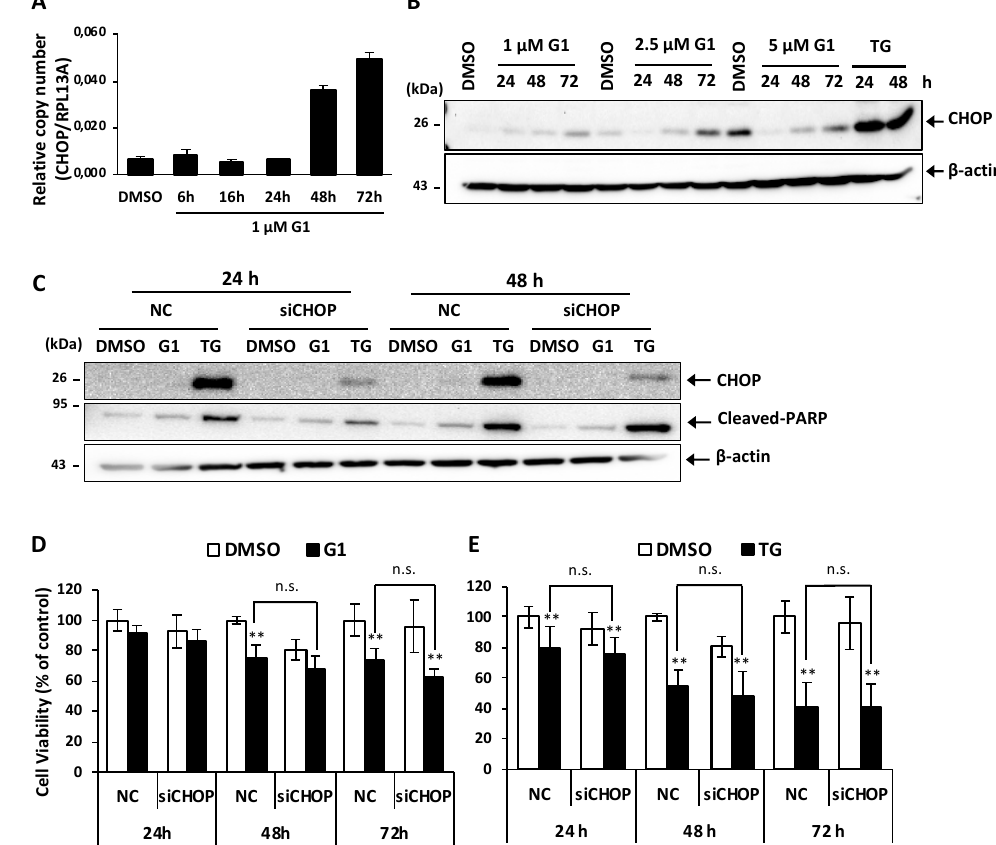
Figure 3. Up-regulation of CHOP expression was not involved in G1-induced cell death in MCF-7 cells. MCF-7 cells were treated with 1, 2.5 and 5 µM G1 at different time points. Total mRNA ( A ) and protein lysates ( B ) were isolated, and the levels of the expression of CHOP-mRNA were measured by real-time PCR and normalized to RPL13A and Western blotting. MCF-7 cells were transfected with siRNA-CHOP or negative control (NC) for 24 h, and then the cells were challenged with 1 µM G1 or 1 µM TG for 24, 48 and 72 h. ( C ) Total protein lysates were subjected to Western blotting using appropriate antibodies. ( D,E ) Cell viability was measured by the LDH activity assay. ** p < 0.01 when compared with cells treated with vehicle.